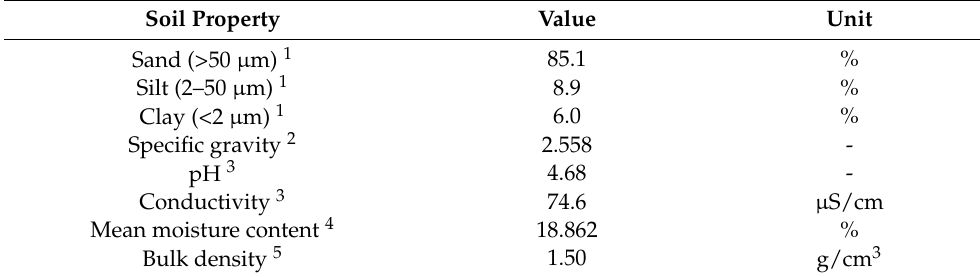
Table 1. Some physical and chemical properties of the